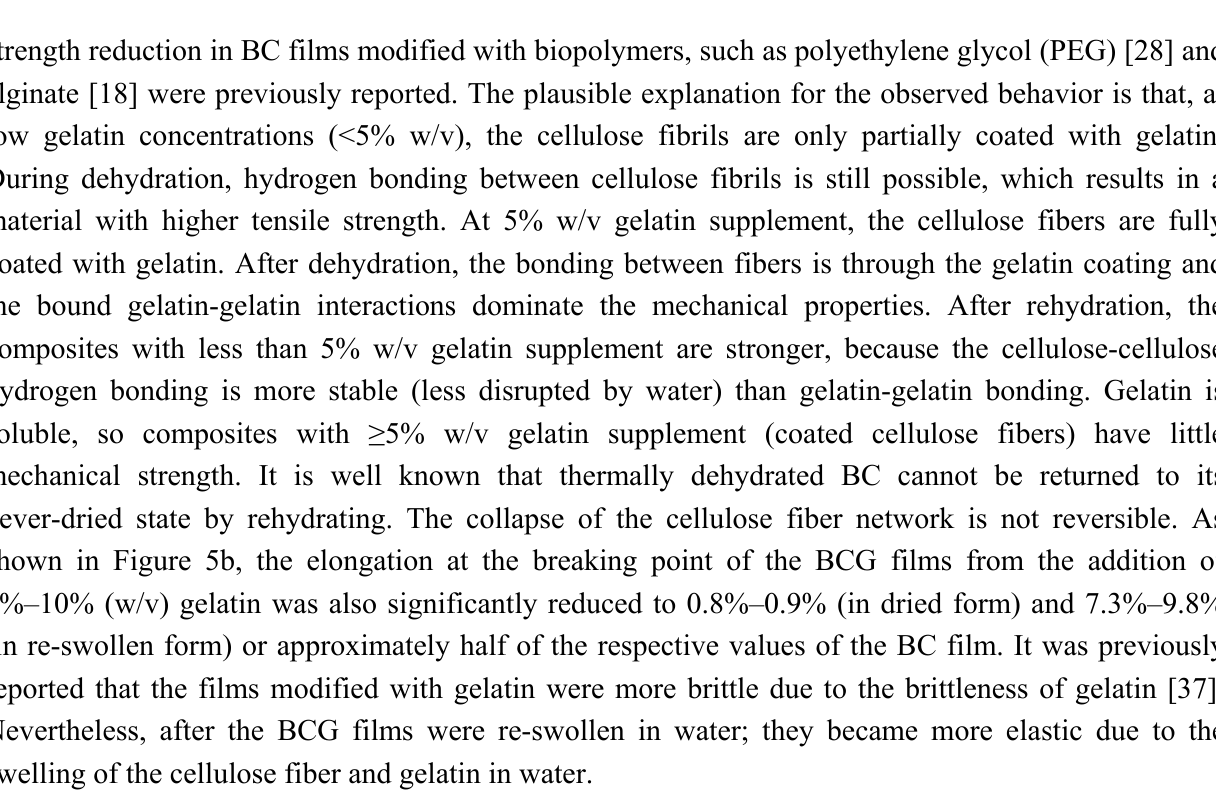
Figure 5. The tensile strength ( a ) and the elongation at break ( b ) of the BC and BCG films as a function of gelatin concentration in culture medium: dried film ( ● ); reswollen film ( ■